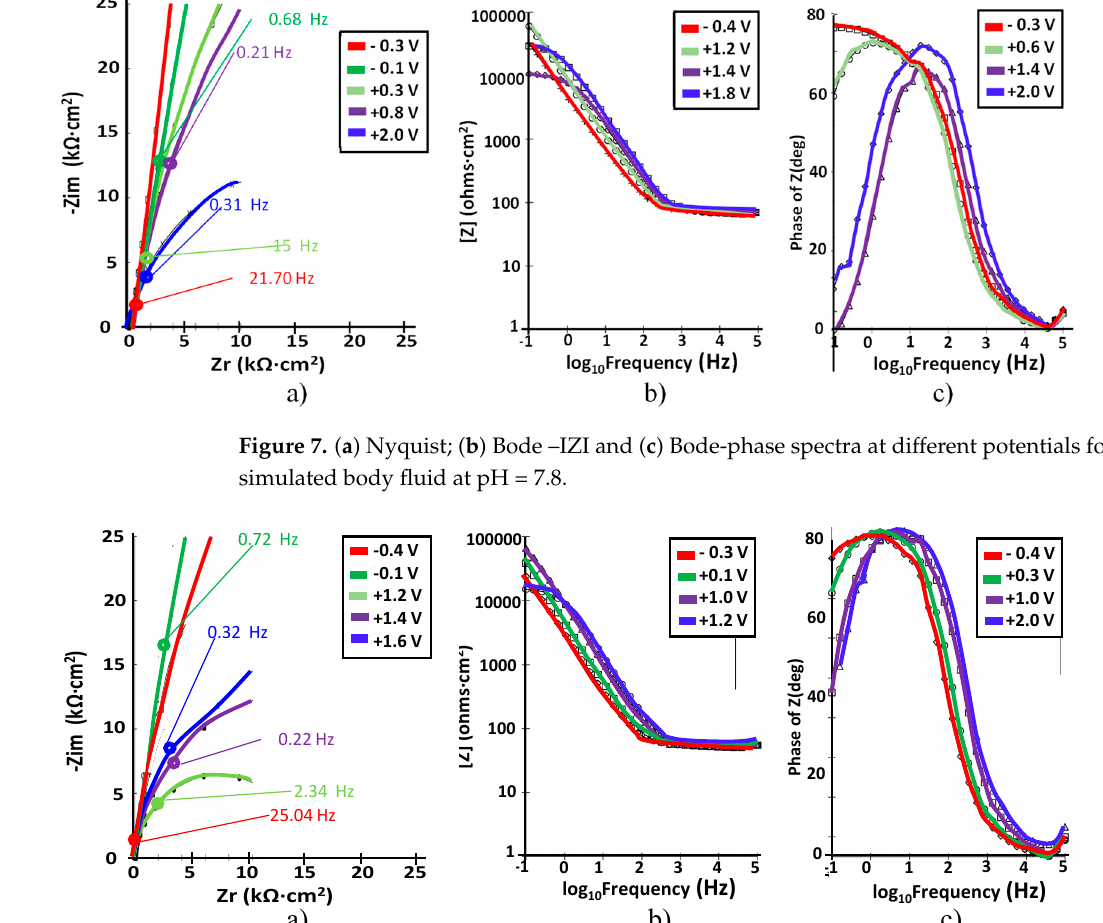
Figure 9. ( a ) Nyquist; ( b ) Bode –IZI and ( c ) Bode-phase spectra at different potentials for Ti–30Ta in simulated body fluid at pH = 7.8. It can be observed that the Nyquist plots revealed the same capacitive loops but with the lowest impedance values compared with the other alloys. It can be seen that the Bode-